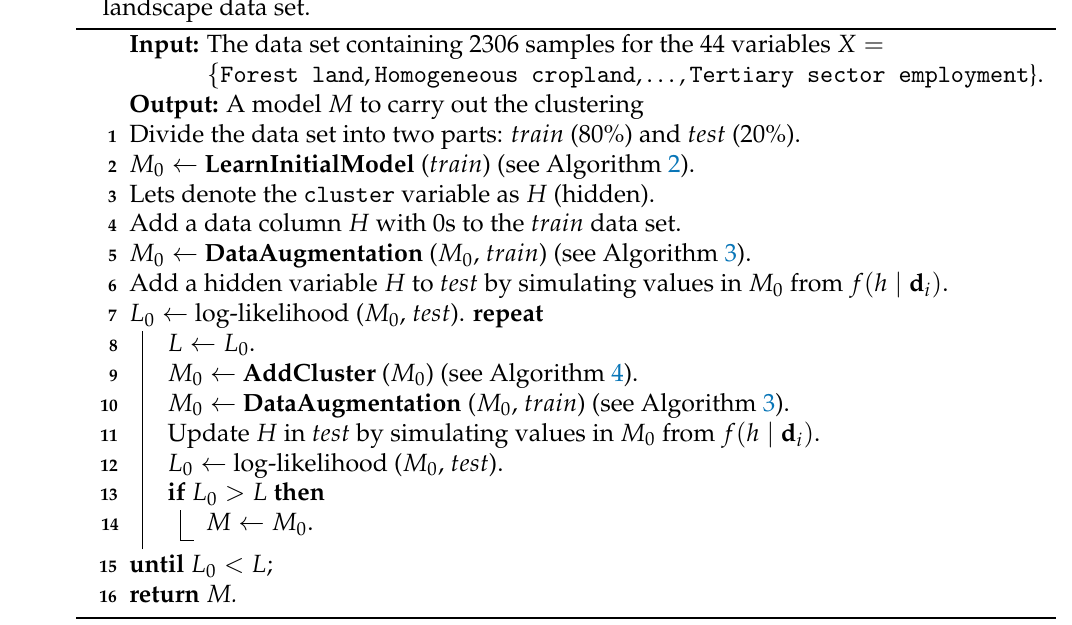
Algorithm 1: Probabilistic clustering based on hybrid Bayesian networks for the landscape data set.